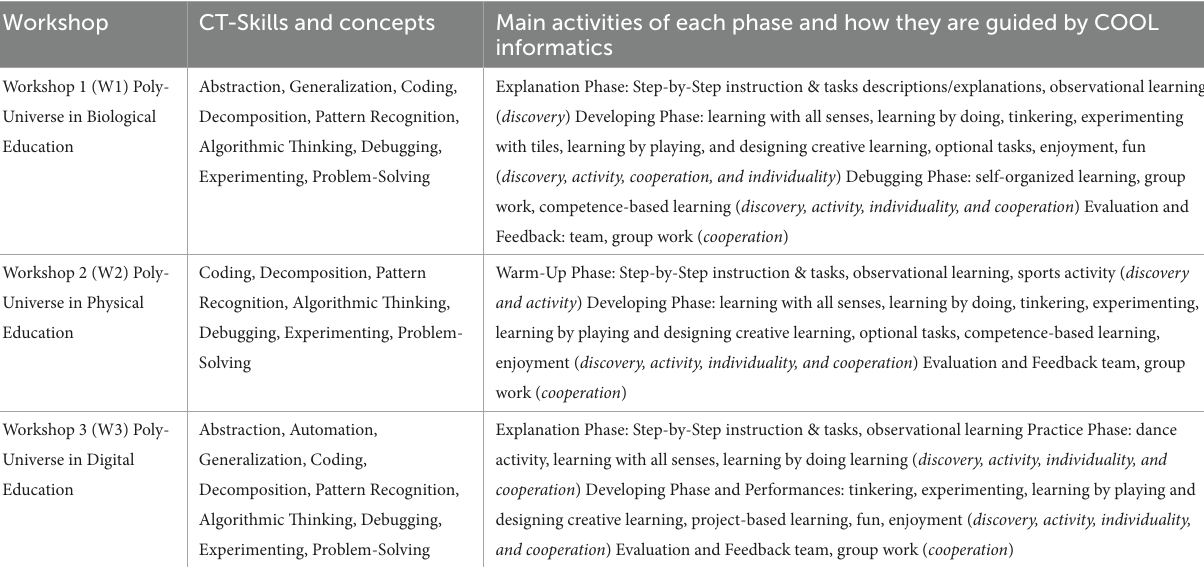
TABLE 1 Overview of all workshops, the CT concepts/skills conveyed in W1-3, and how they were guided by the COOL informatics concept (Sabitzer, 2013; Sabitzer and Stefan Pasterk, 2013).